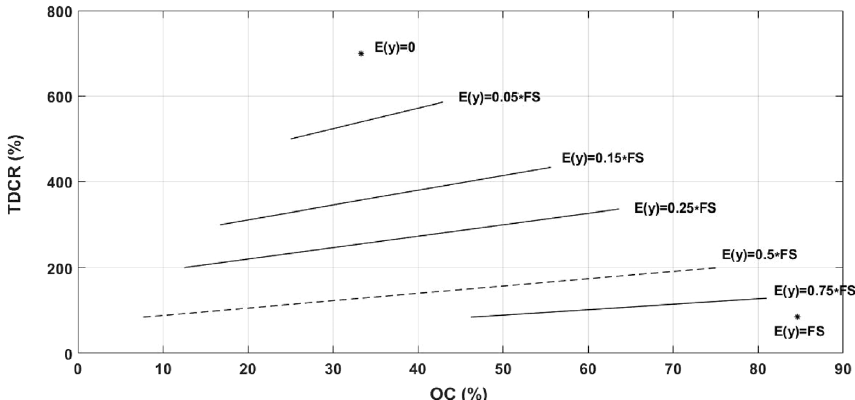
Figure 4. TDCR-OC loci for signals with different expected values (for M G =